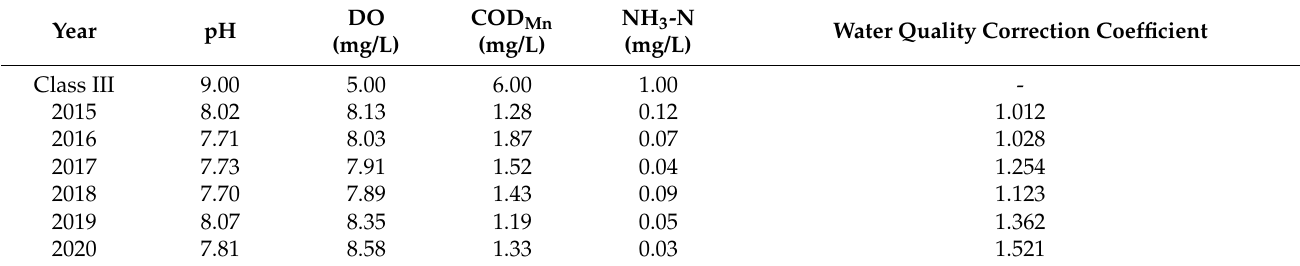
Table 6. Water quality correction coefficient of the main headwater areas from 2015 to